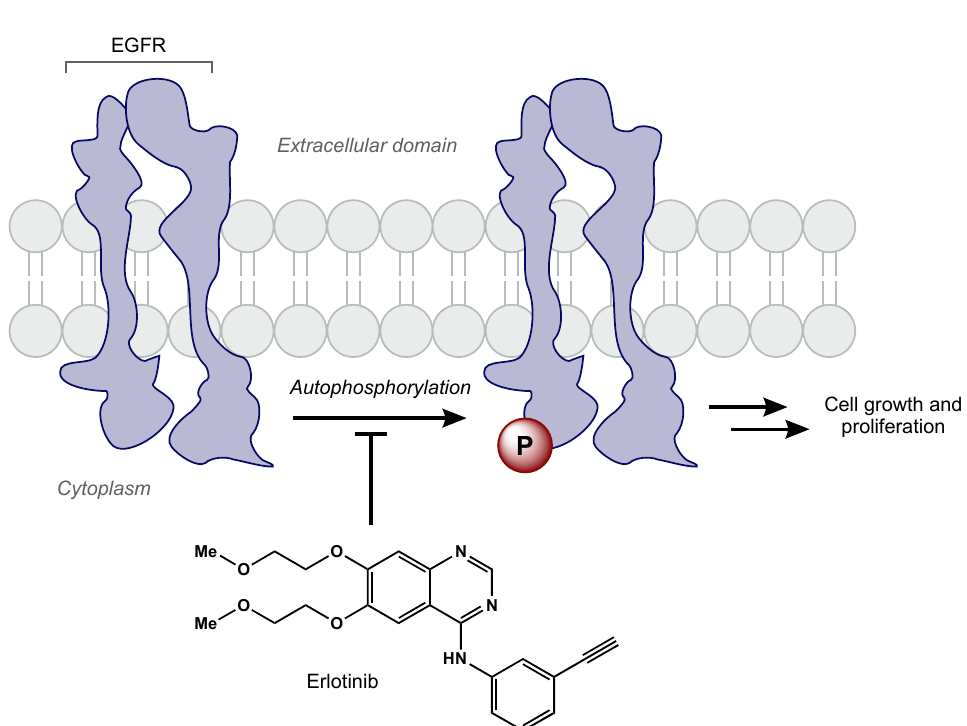
Figure 3. Erlotinib reversibly inhibits EGFR tyrosine kinase activity, which prevents cell growth and proliferation of cancer cells.